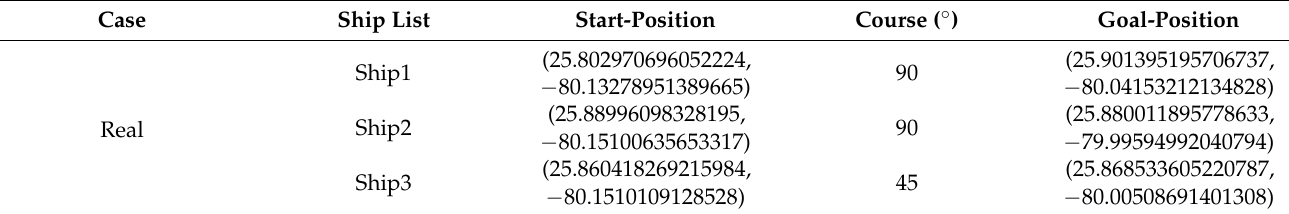
Table 3. Data of real ship under three-ship encounter